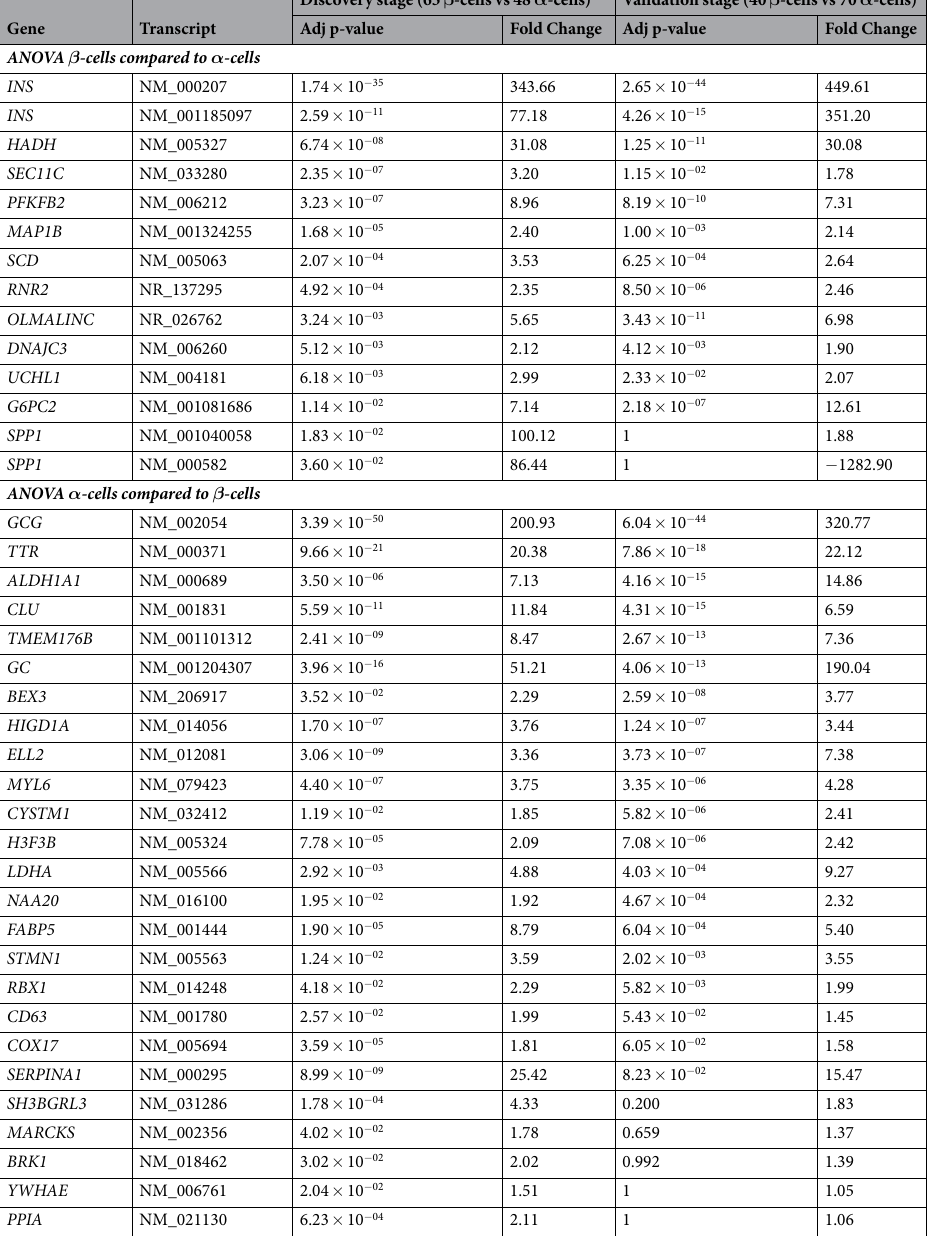
Table 1. Significant transcripts and genes from ANOVA analysis of (1) β -cells compared to α -cells and (2) α -cells compared to β -cells in our study. Cells from patient 1 and 2 used in discovery stage and cells from patient 3 used for validation. Discovery stage p-value adjusted for 582 transcripts tested (RPKM > 50 in at least 25% of cells). Validation stage p-value adjusted for 14 and 25 transcripts tested,